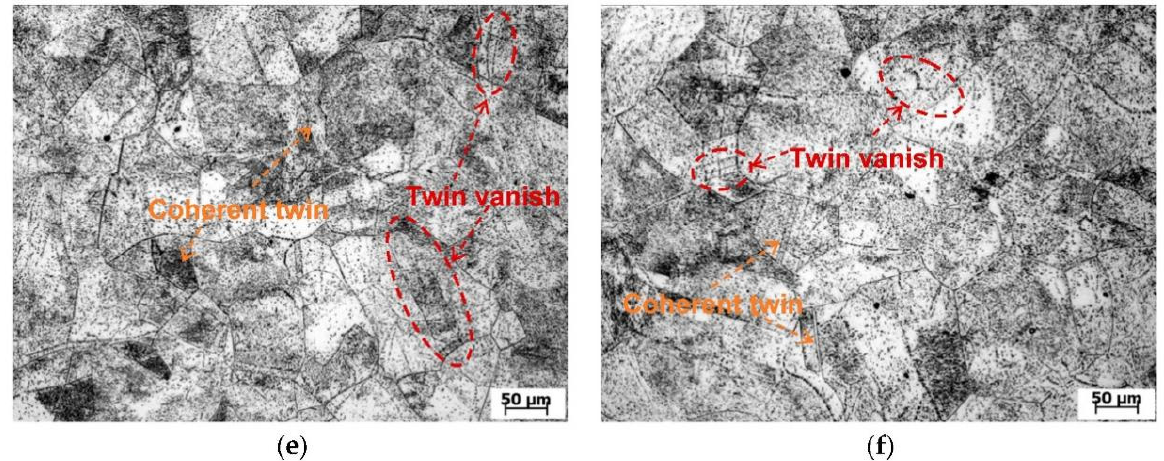
Figure 1. Metallurgical structure observations of 316 LNSS during thermal aging: ( a ) origin, ( b ) 50 h, ( c ) 100 h, ( d ) 200 h, ( e ) 300 h, and ( f ) 500 h.